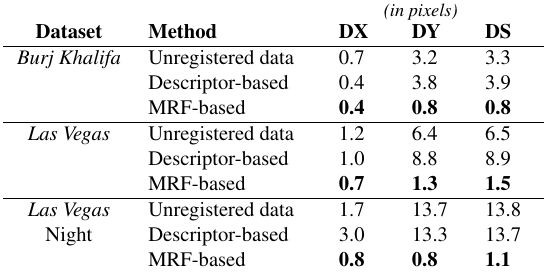
Table 2: Quantitative evaluation results after the application of the proposed MRF-based registration method. In all cases the developed approach managed to registered the satellite video fra- mes with a mean displacement error of less than 1.5